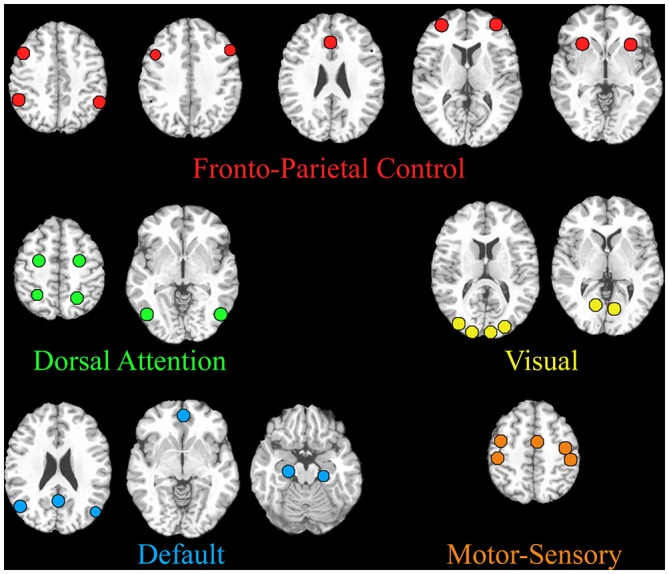
Regions included in the seed-based network analysis are shown. The MNI coordinates are listed in Table 1.